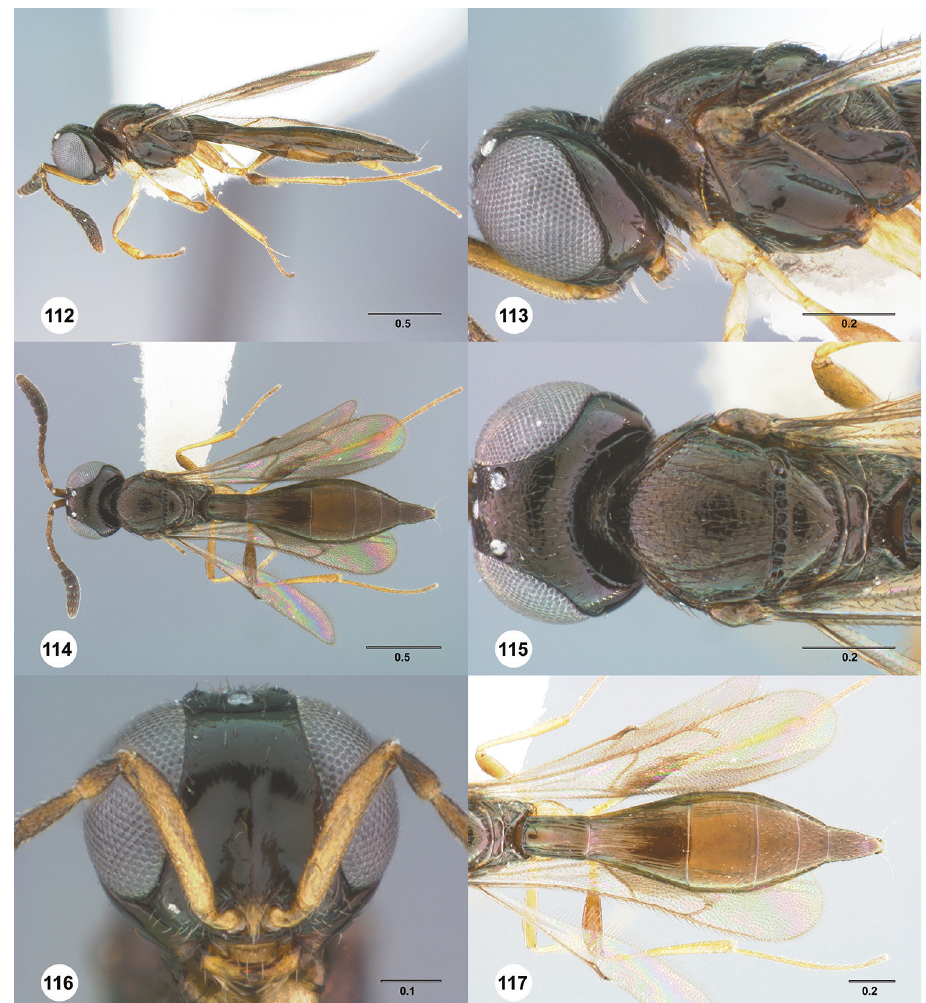
Figures 112–117. Calliscelio foveolatus sp. n., female, holotype (OSUC 532869). 112 Lateral habi- tus 113 Head and mesosoma, lateral view 114 Dorsal habitus 115 Head and mesosoma, dorsal view 116 Head, anterior view 117 Metasoma, dorsal view. Scale bars in